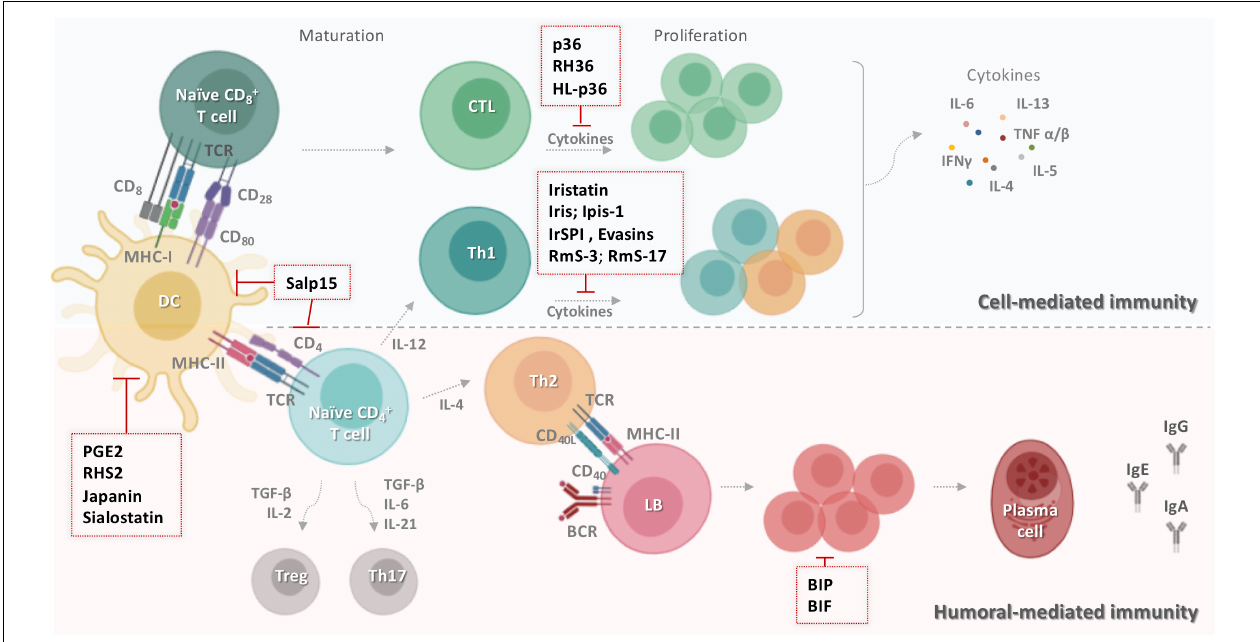
FIGURE 3 | Schematic representation of tick salivary molecules targeting adaptive immunity. During the primary contact with ticks, dendritic cells present salivary antigens to lymphocytes, which trigger cell- and humoral-mediated responses. Some tick salivary molecules prevent the initiation of adaptive immunity by targeting DCs, including Salp15, PGE 2 , RHS2, Japanin, and sialostatin. Other compounds block the proliferation of lymphocytes and/or inhibit the production of T cell cytokines such as p36, RH36, HL-p36, Iristatin, Iris, Ipis-1, IrSPI, Evasins, RmS-3, and RmS-17. However, BIP and BIF disarm humoral host immunity by inhibiting B cell responses, including the production of specific anti-tick antibodies. BCR: B cell receptor; BIF: B cell inhibitory factor; BIP: B cell inhibitory protein; CD: cluster of differentiation; CTL: cytotoxic T lymphocyte; DC: dendritic cells; HL-p36: Haemaphysalis longicornis p-36; IFN- γ : interferon gamma; Ig: immunoglobulin; IL: interleukin; LB: lymphocyte B; MHC: major histocompatibility complex; PGE 2 : prostaglandin E2; RmS: Rhipicephalus microplus serpin; Salp: salivary protein; TCR: T cell receptor; TGF- β : transforming growth factor-beta; Th: T helper; TNF: tumor necrosis factor; Treg: regulatory T